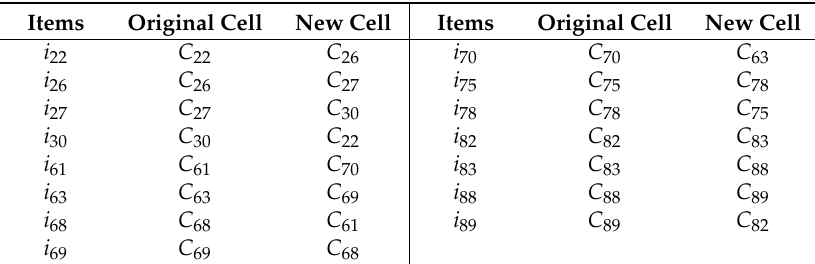
Table 4. Reassignment result for 15 opportunity items for